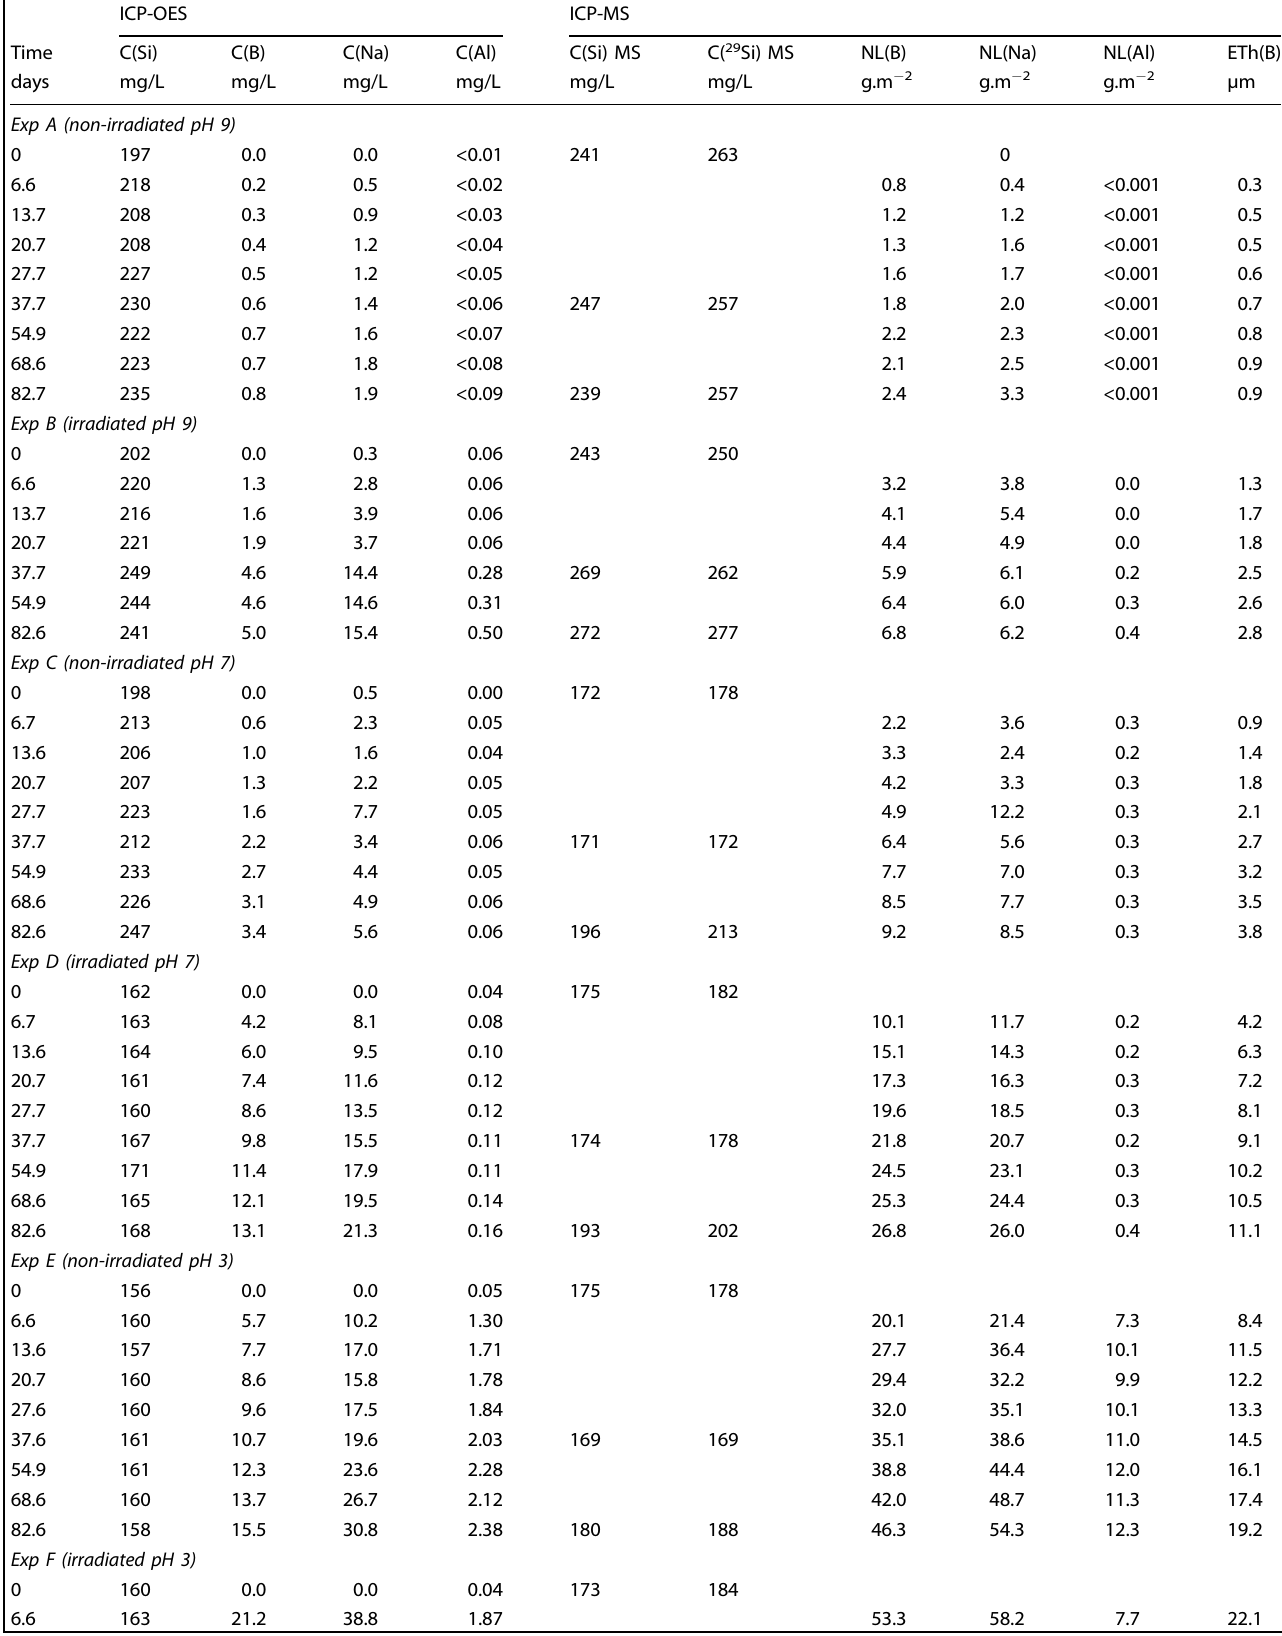
Table 1. Solution data sets. Concentrations measured by ICP-OES and ICP-MS, normalized mass losses and equivalent thicknesses of B. ICP-OES